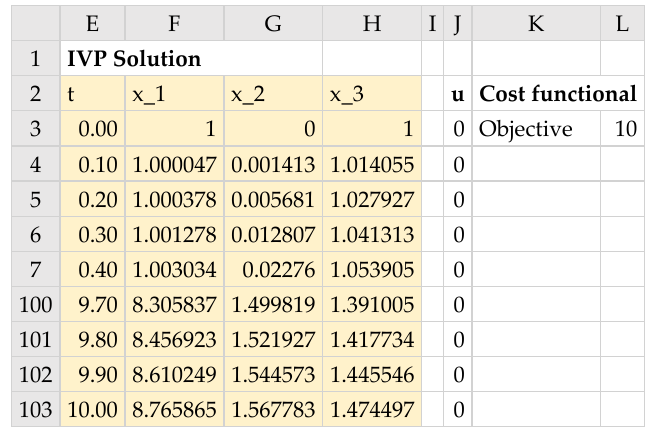
Figure 21. Partial listing of computed result by Formula (37). Also shown are generated control column and the initial objective formula value. The associated formulas are listed in Table 5.